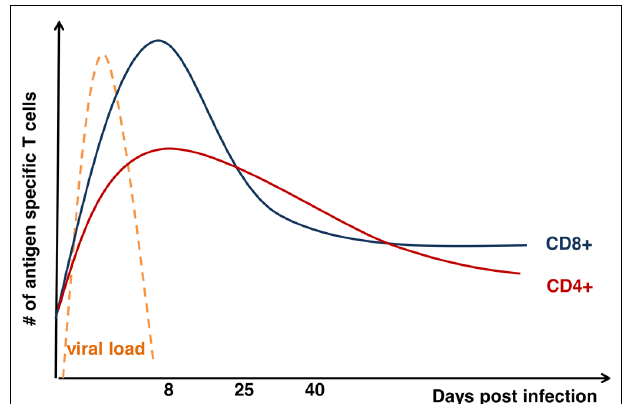
FIGURE 1 | Kinetics ofT cell response after acute viral infection. Graph shows total numbers ( y -axis) of antigen-specific CD8 + (blue) and CD4 + (red)T cells days ( x -axis) after acute infection as modified from Hinds etal. (2007). Kinetics of viral load (orange) is also displayed on the